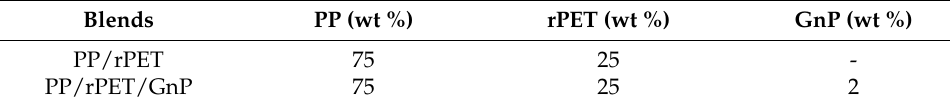
Table 1. Composition of the studied blends.